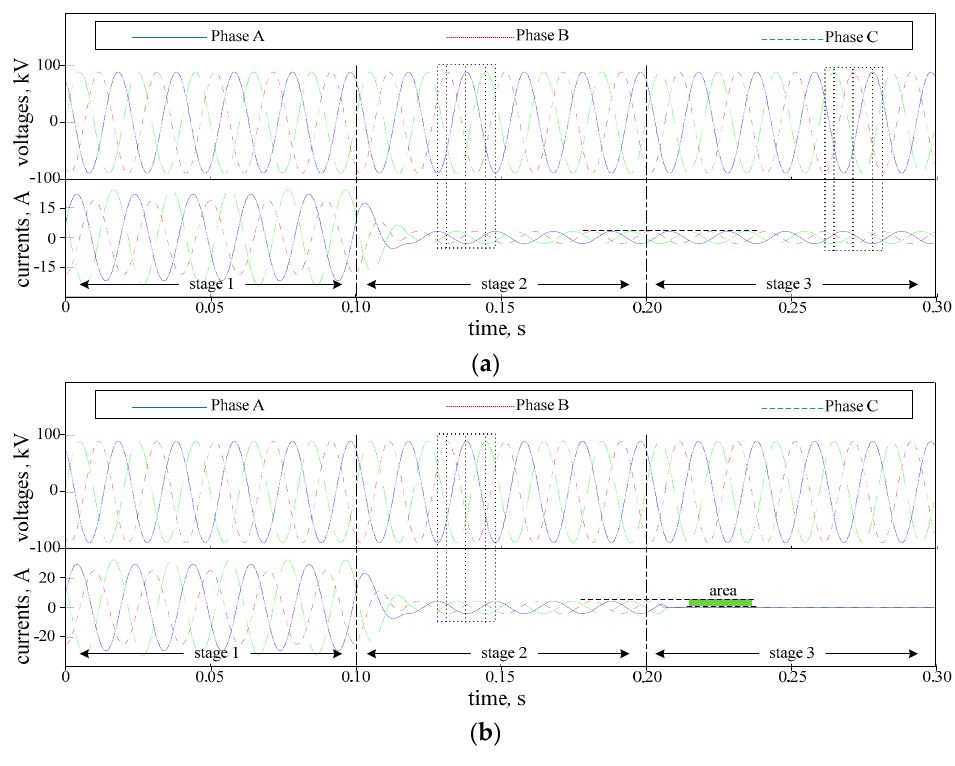
Figure 28. Results of power quality improvement under decentralized control and centralized control ( a ) decentralized control; ( b ) centralized control.